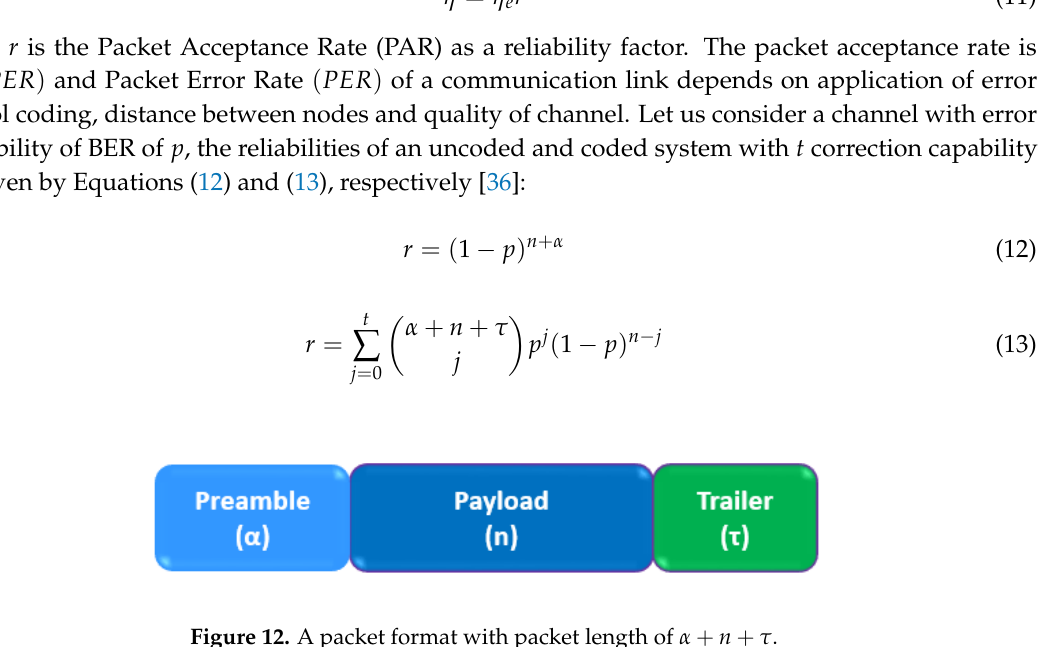
Figure 12. A packet format with packet length of α + n + τ